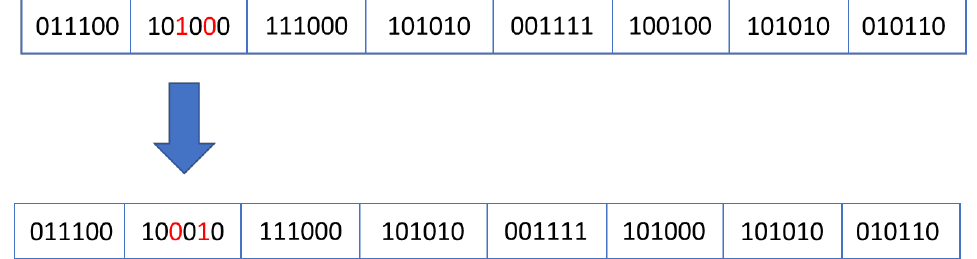
Figure 5. Representation of the mutation process. One element of the individual is randomly selected and its content is randomly modified.